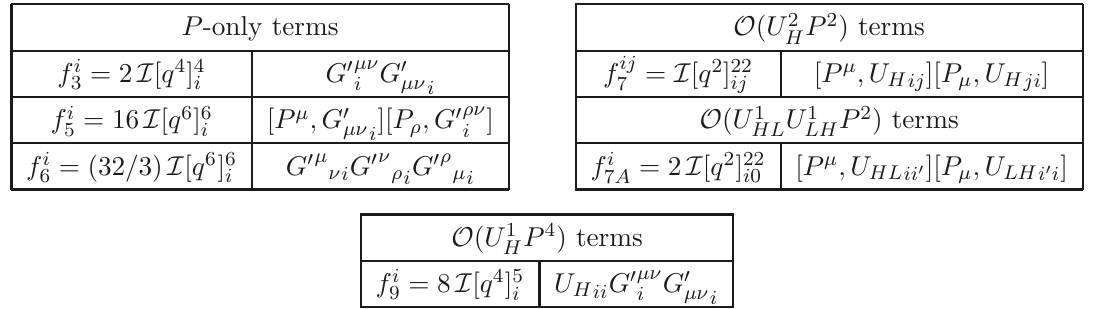
, f i , and f i for operators involving only P . There are 3 3 5 6 and f i for operators at O ( U 2 P 2 ). There are 2 7 7 A for operators at O ( U 1 P 4 ). 9